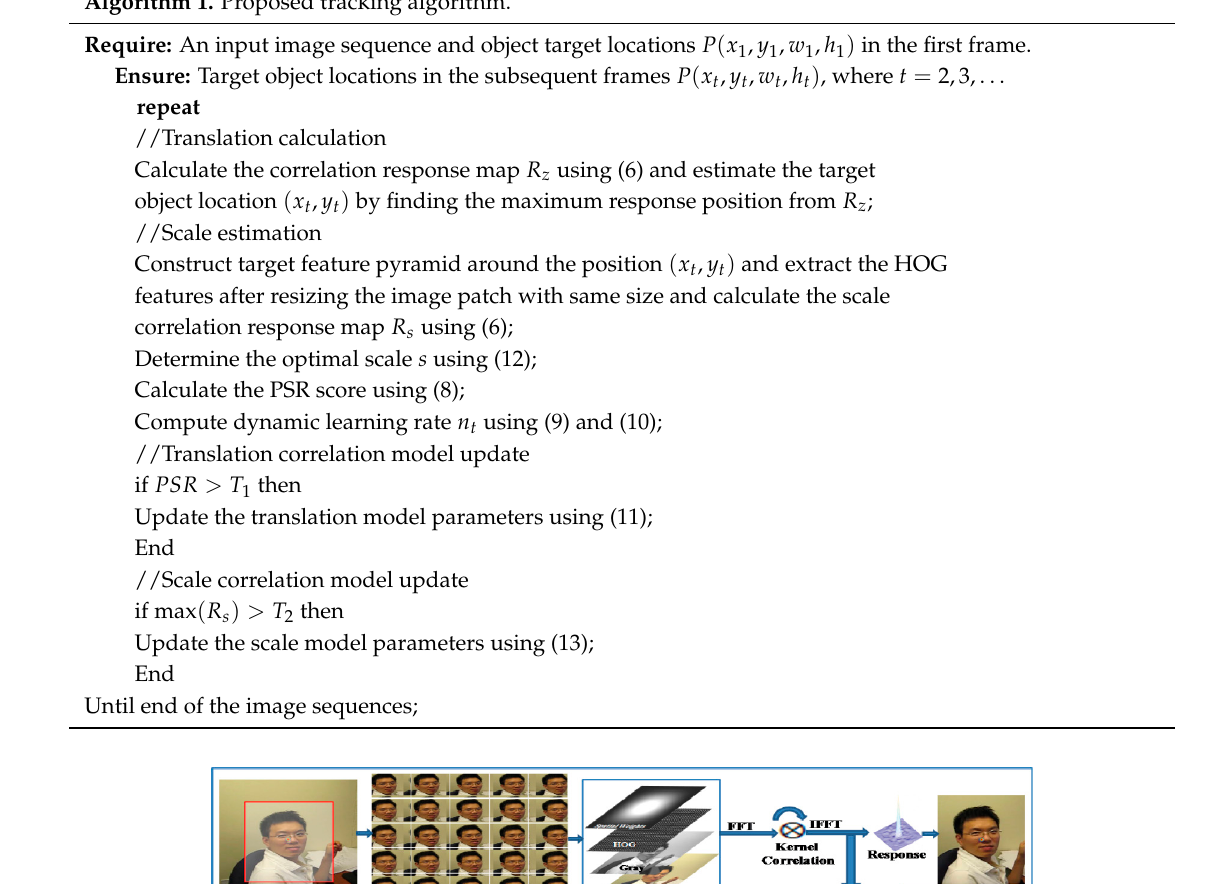
Algorithm 1. Proposed tracking algorithm.